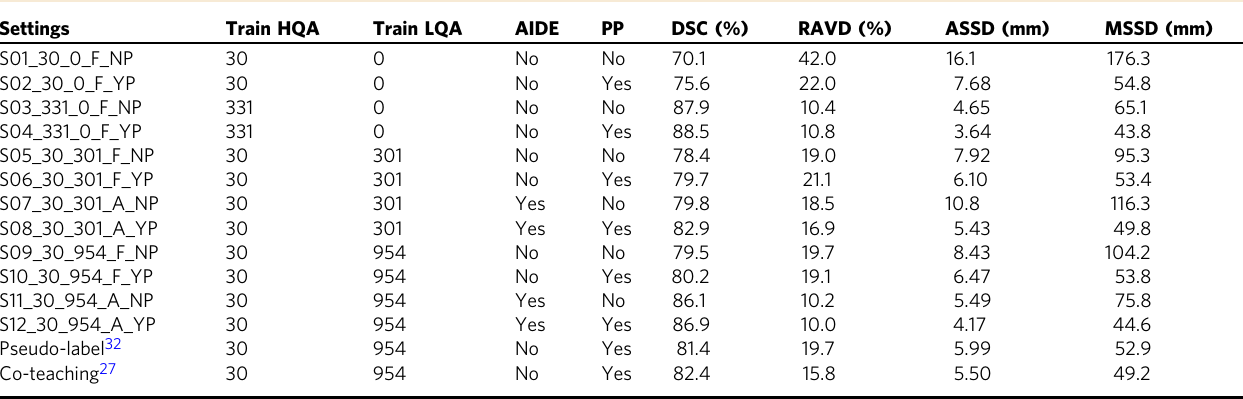
HQA and LQA indicate high-quality and low-quality annotations. LQAs are generated by the model trained using the data provided with HQAs. PP refers to post-processing, which is the process of keepingthelargestconnectedcomponents.Contextisincludedinthenotationoftheexperimentalsetting.ForthesettingS05_30_301_F_NP,30refersto30trainingsampleswithHQAs,301means301 training samples with LQAs, F indicates training with the conventional fully supervised learning approach, and NP means no